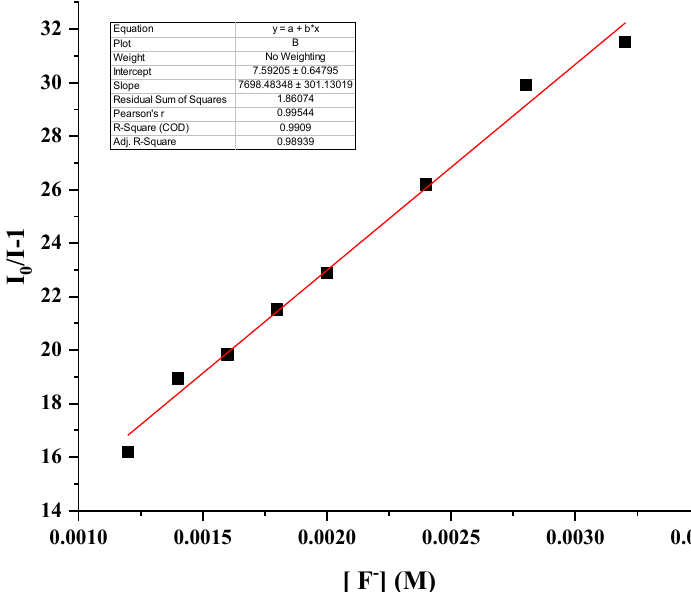
Figure 13. Stern-Volmer plot of fluorescence quenching due to interaction between sensor R1 and fluoride ion.